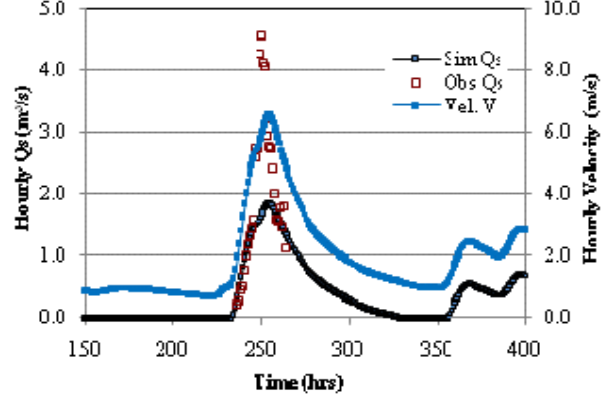
Fig. 10. Correlation of observed and simulated hourly water discharge at Tateyama station (11 July 2002) ( N = number of observations).